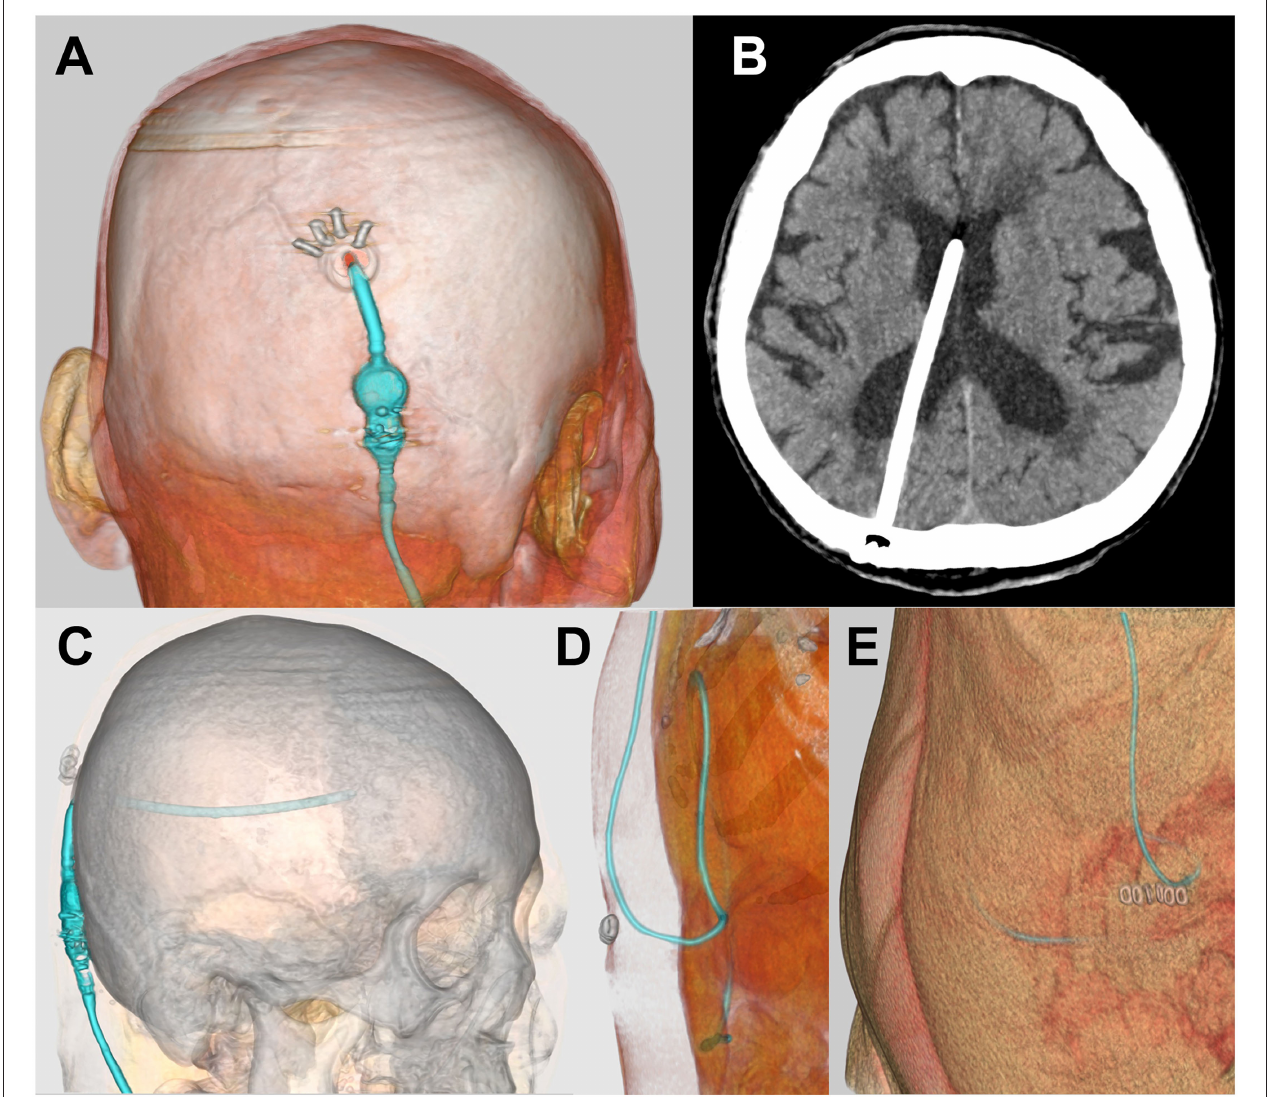
FIGURE 5 | Postoperative CT images. Postoperative head CT images (A–C) and abdominal CT images (D,E) created by SYNAPSE 3D workstation were